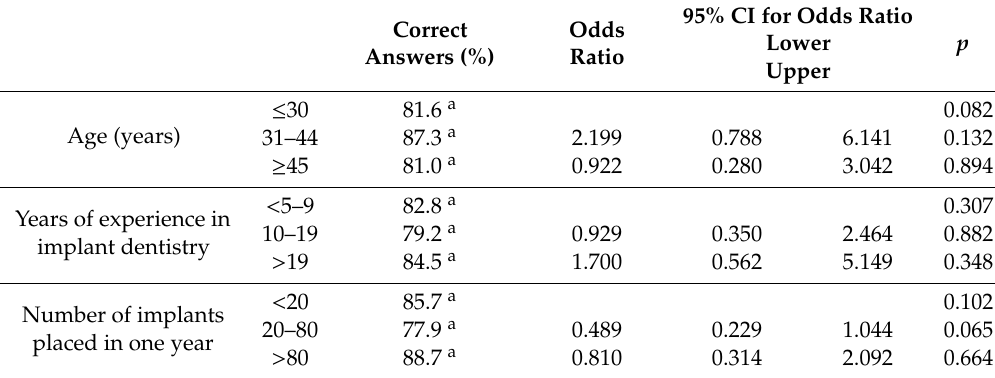
Multivariable analysis considering the correct answers on the symptoms of retrograde peri-implantitis.